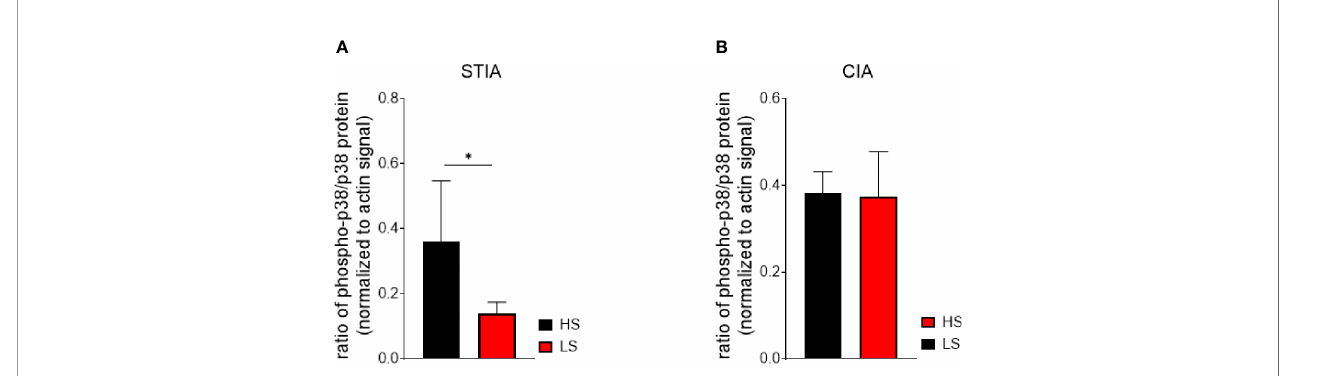
FIGURE 8 | Activation of p38 MAPK is inhibited in the effector phase of arthritis (STIA) by LS diet. Whole splenocyte lysates of STIA (A) and CIA (B) mice were immunoblotted for phospho-p38 MAPK, p38 MAPK, and beta-actin. Ratios of phospho-p38:p38 were calculated from experimental signals (LS, n = 5 HS, n = 5). * p < 0.05. p -values were calculated by Student ’ s t -test. All data were expressed as